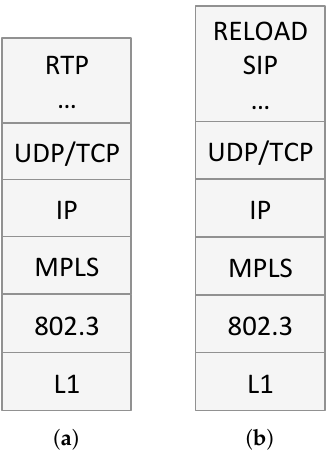
Figure 5. Core network node protocol stack. ( a ) User Plane; ( b ) Control